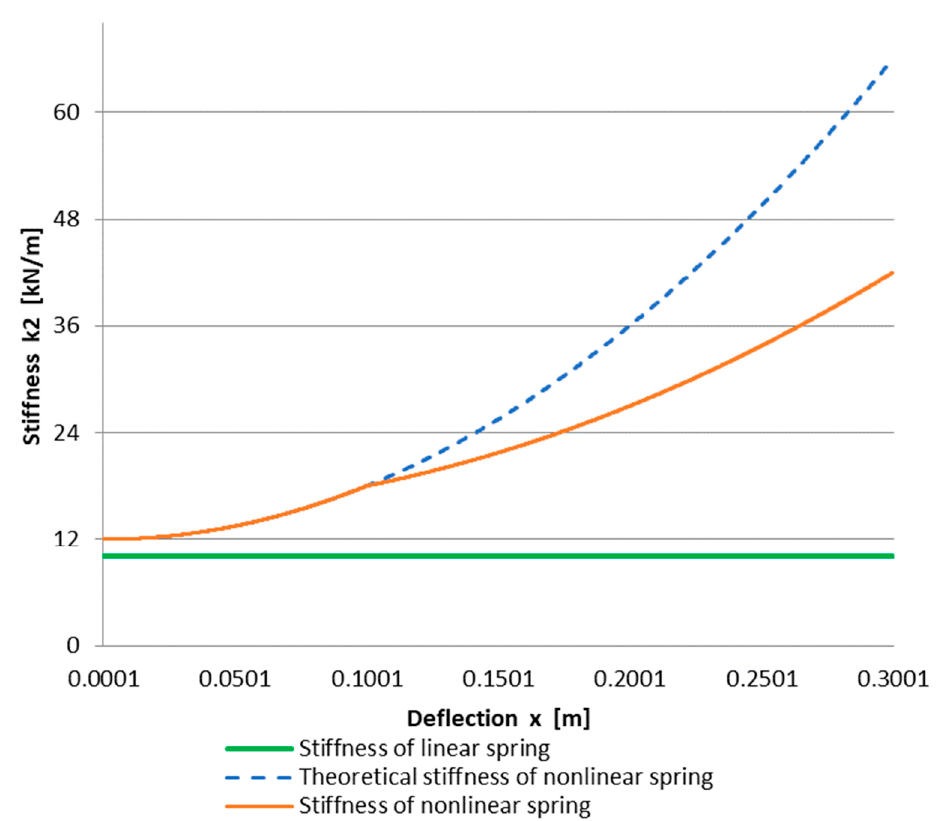
Figure 2. Suspension spring 𝑘 (cid:2870) characteristics.